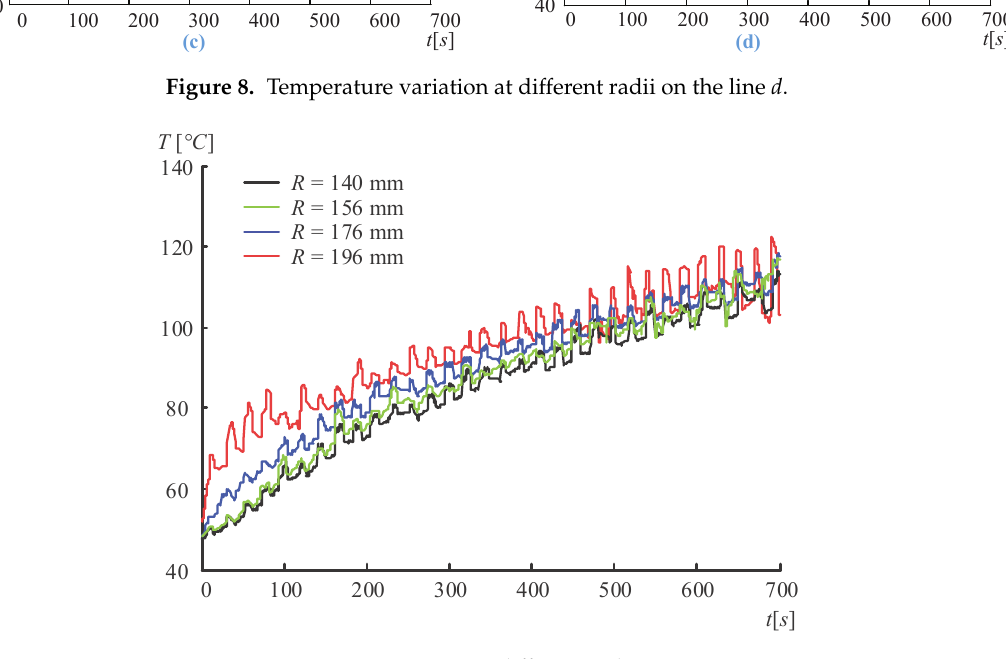
Figure 9. Temperature variation at different